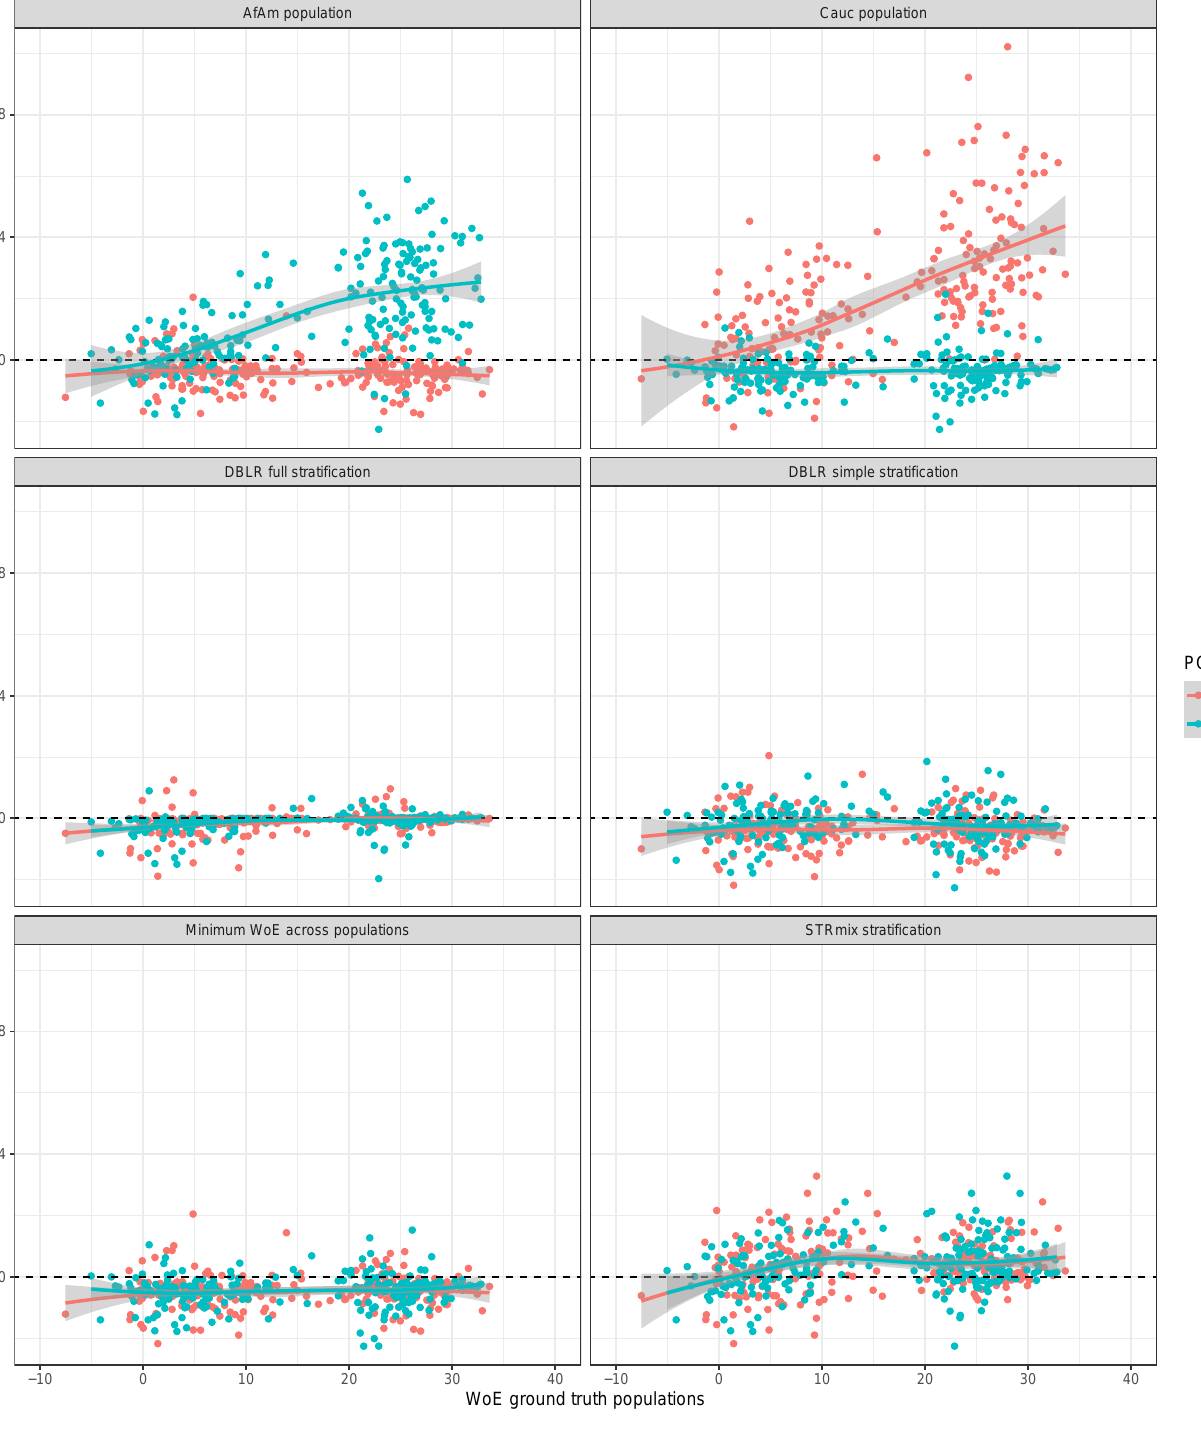
Figure 2. WoE difference the compared methods and the WoE evaluated the ground truth populations with F ST = 0 for the 500 donors to the 250 simulated two-person mixtures where the contributors originate from different